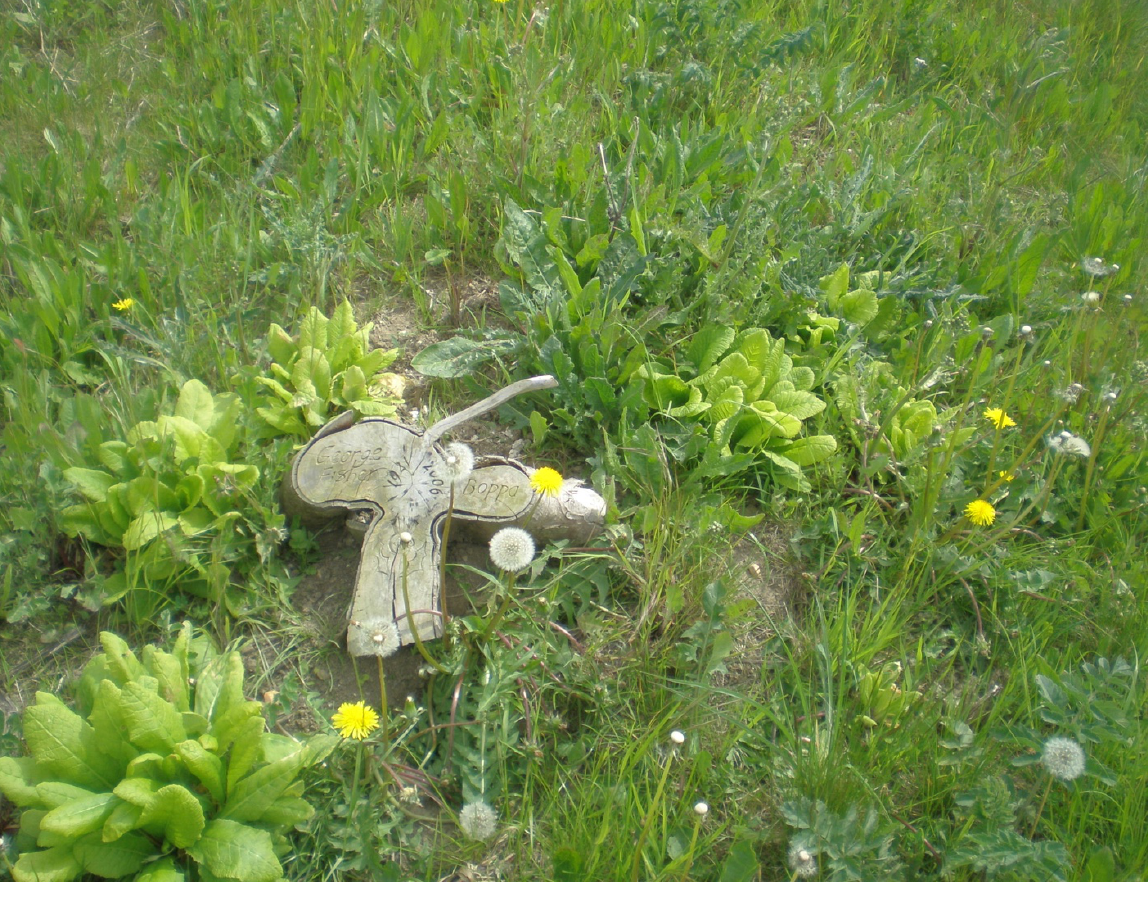
Fig 3 A grave marked by a wooden plaque and planted